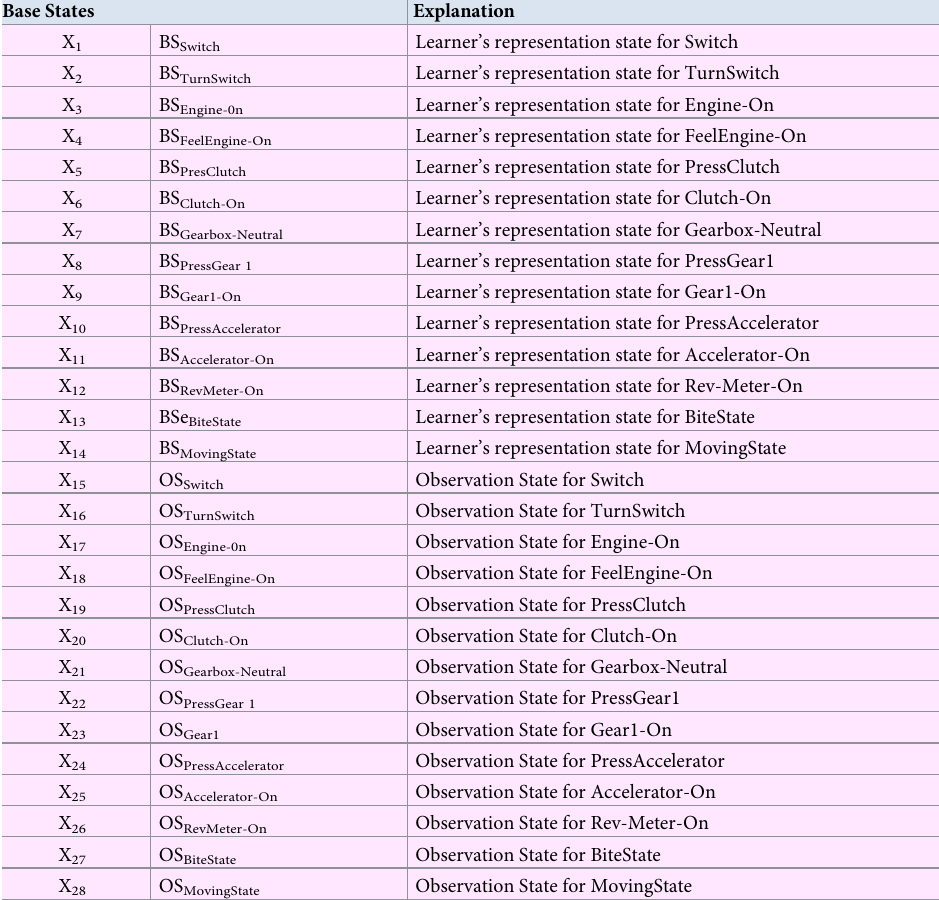
Table 3. Explanation of the base level states for the mental model within the network